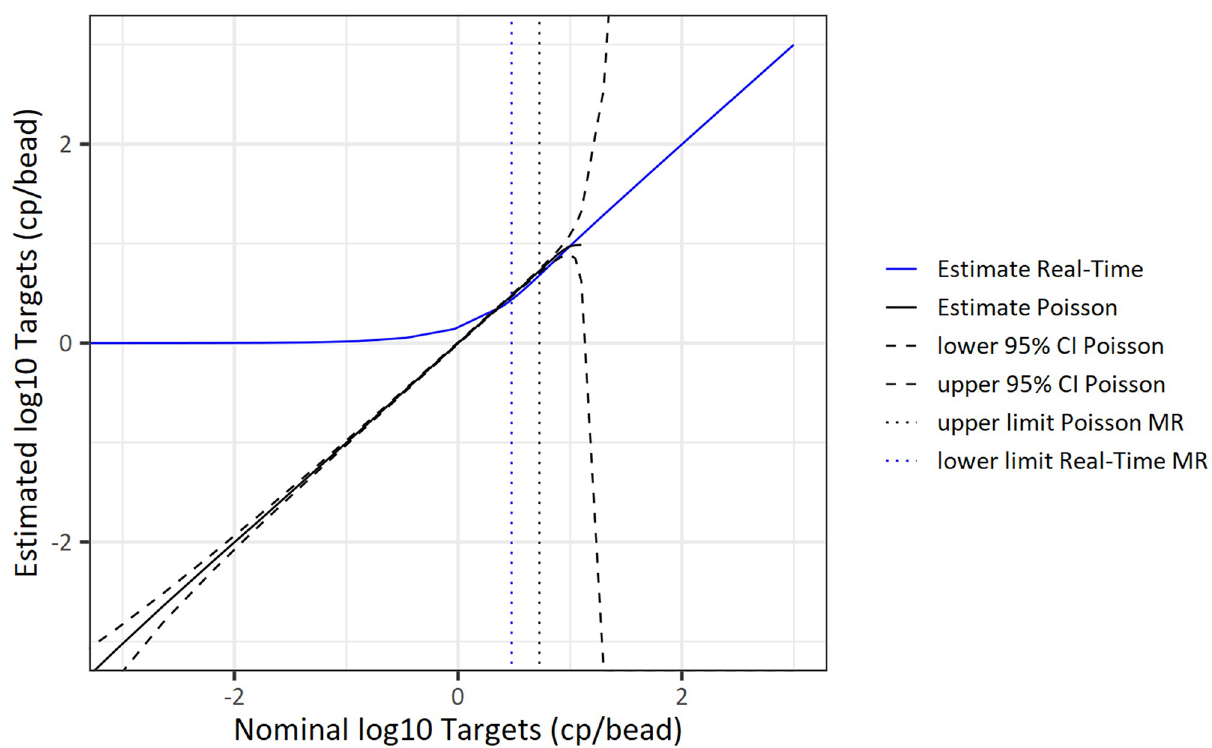
Fig 5. Overlap of measuring ranges (MR) of digital PCR and real-time quantitative PCR.